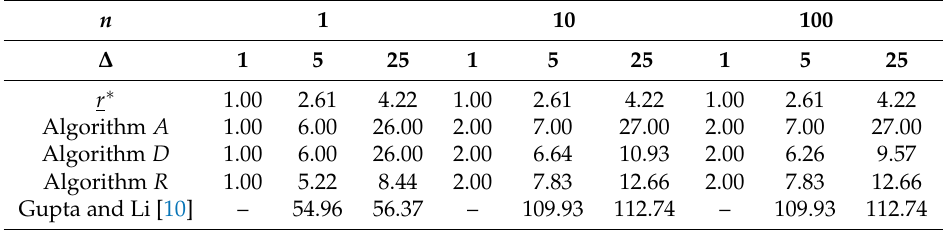
Table 3. Numerical values of lower bound on CRs from Theorem 6 and either CRs or upper bounds